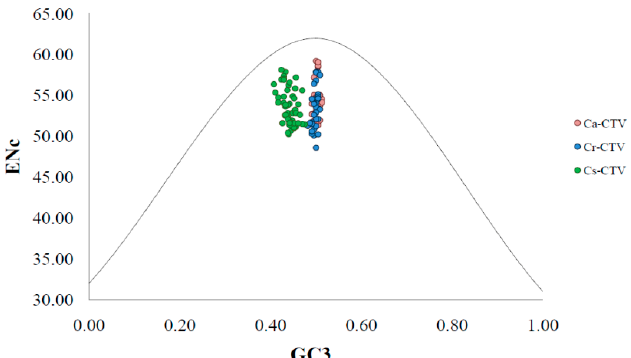
Figure 1. ENc-GC3 plot analysis of the coat protein ( CP ) genes of Citrus tristeza virus (CTV) isolates. ENc denotes the effective number of codons, and GC3 denotes the GC content at the third synonymous codon position. The black dotted line represents the expected curve derived from the positions of strains when the codon usage is only determined by the GC3 composition. Different CTV subgroups are indicated as Ca-CTV, Cr-CTV, and Cs-CTV (from Citrus aurantifolia , C. reticulata , and C. sinensis , respectively) with different color markers as shown to the right of the figure.